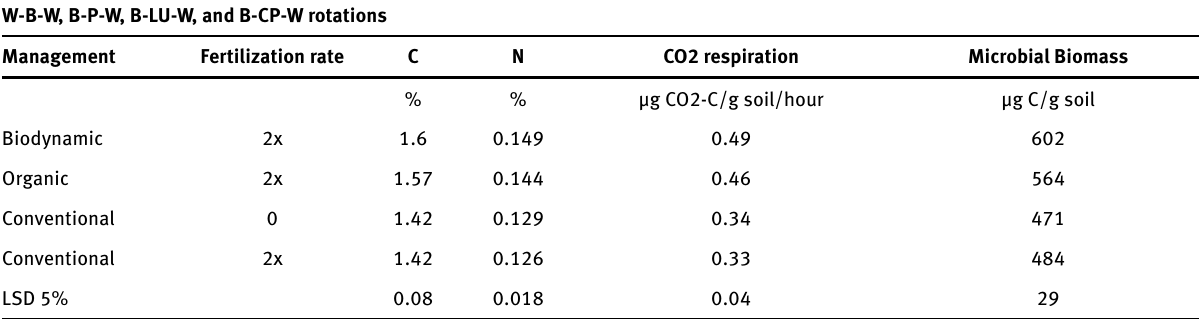
Table 2: Effects of management on soil characteristics in 1985 over the